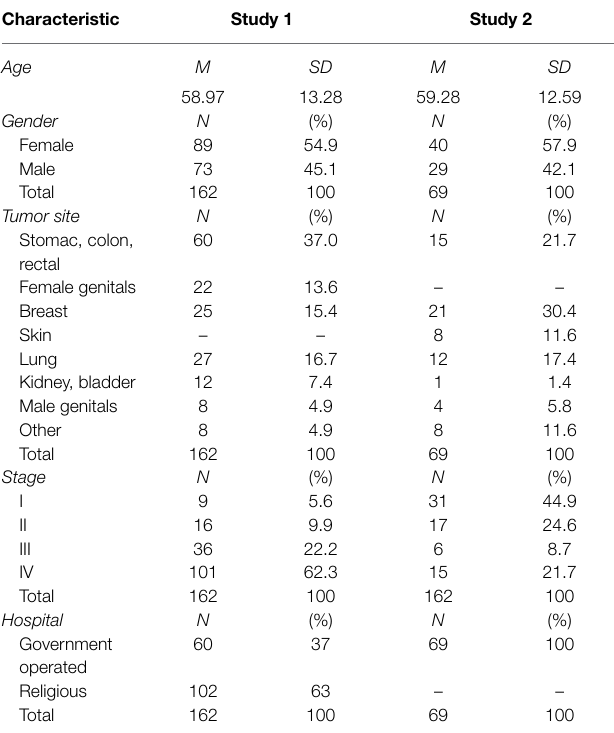
TABLE 1 | Patient characteristics (Study 1 and